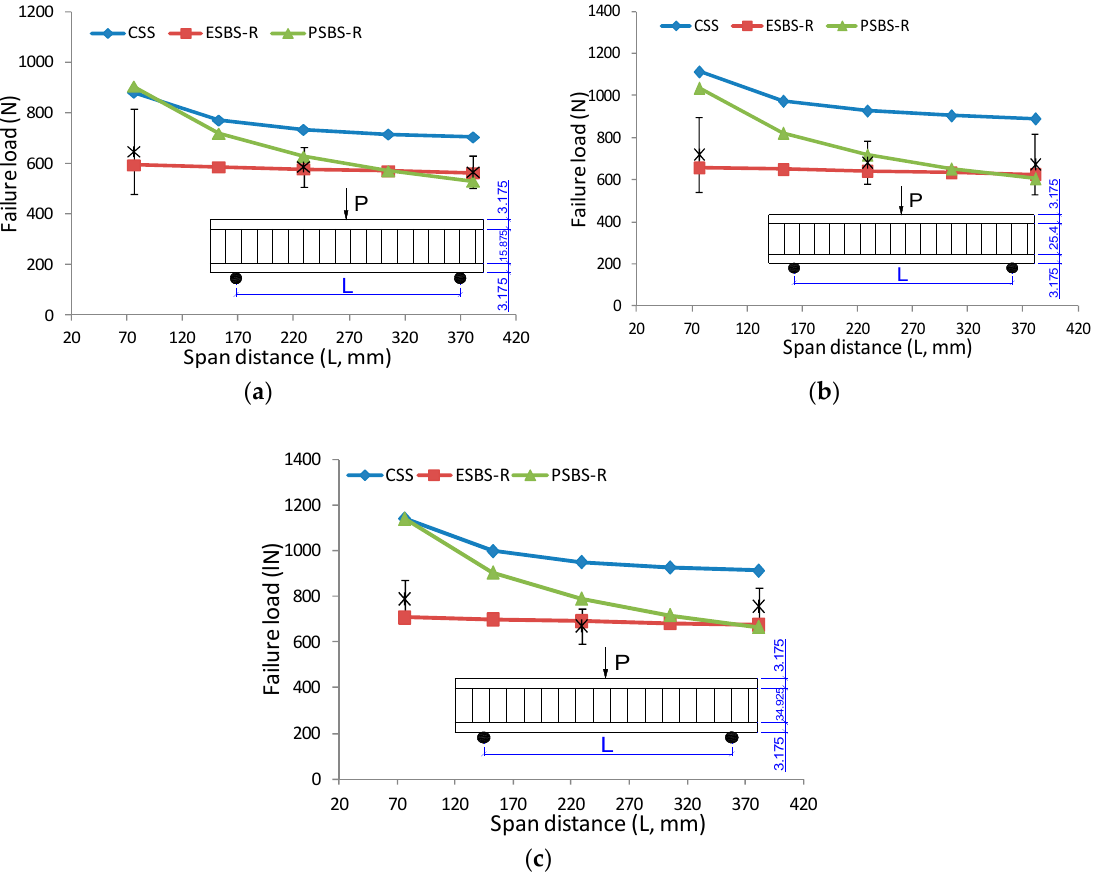
Figure 9. The effect of face sheets type on failure load of sandwich beam under three-point bending.